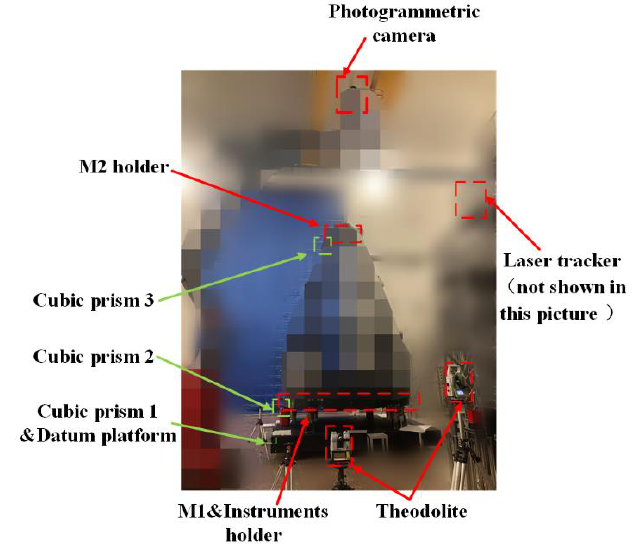
Figure 14. The experimental site. (Due to the protection of intellectual property rights, we are reluctant to release specific design details of the truss structure at this time).